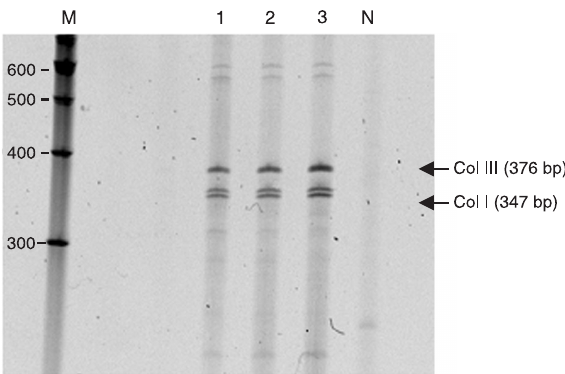
Figure 2. Gel electrophoresis of polymerase chain reaction prod- ucts visualized by Sybr gold staining. M indicates DNA molecular weight markers. N indicates negative control. Col III, Col I = collagen types III and I. Data are representative of three experi- ments.